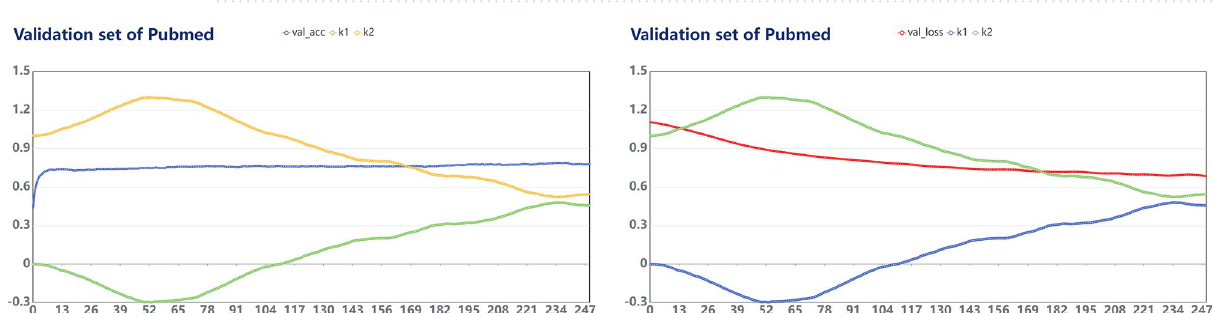
Figure 11. Pubmed: Fitting relationship between val_acc, val_loss and